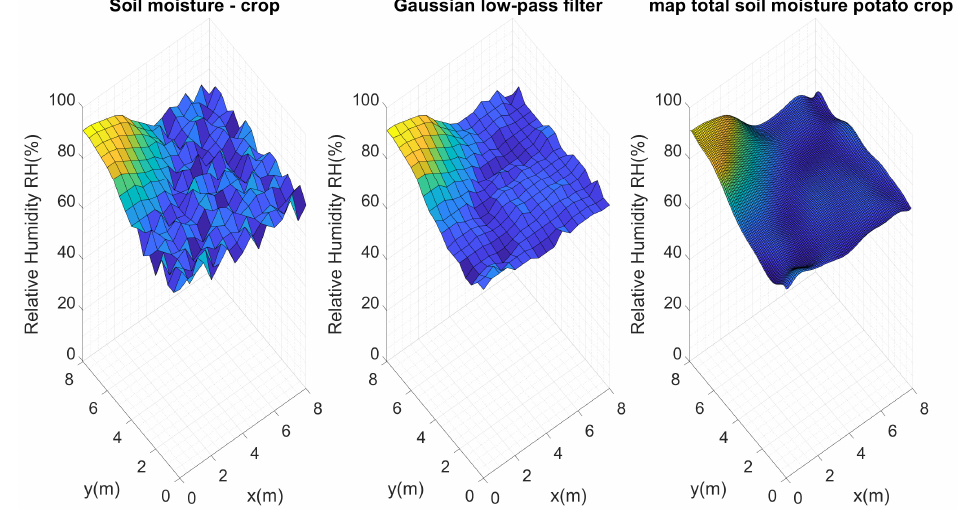
Figure 13. Irrigation focused on one end of the crop.